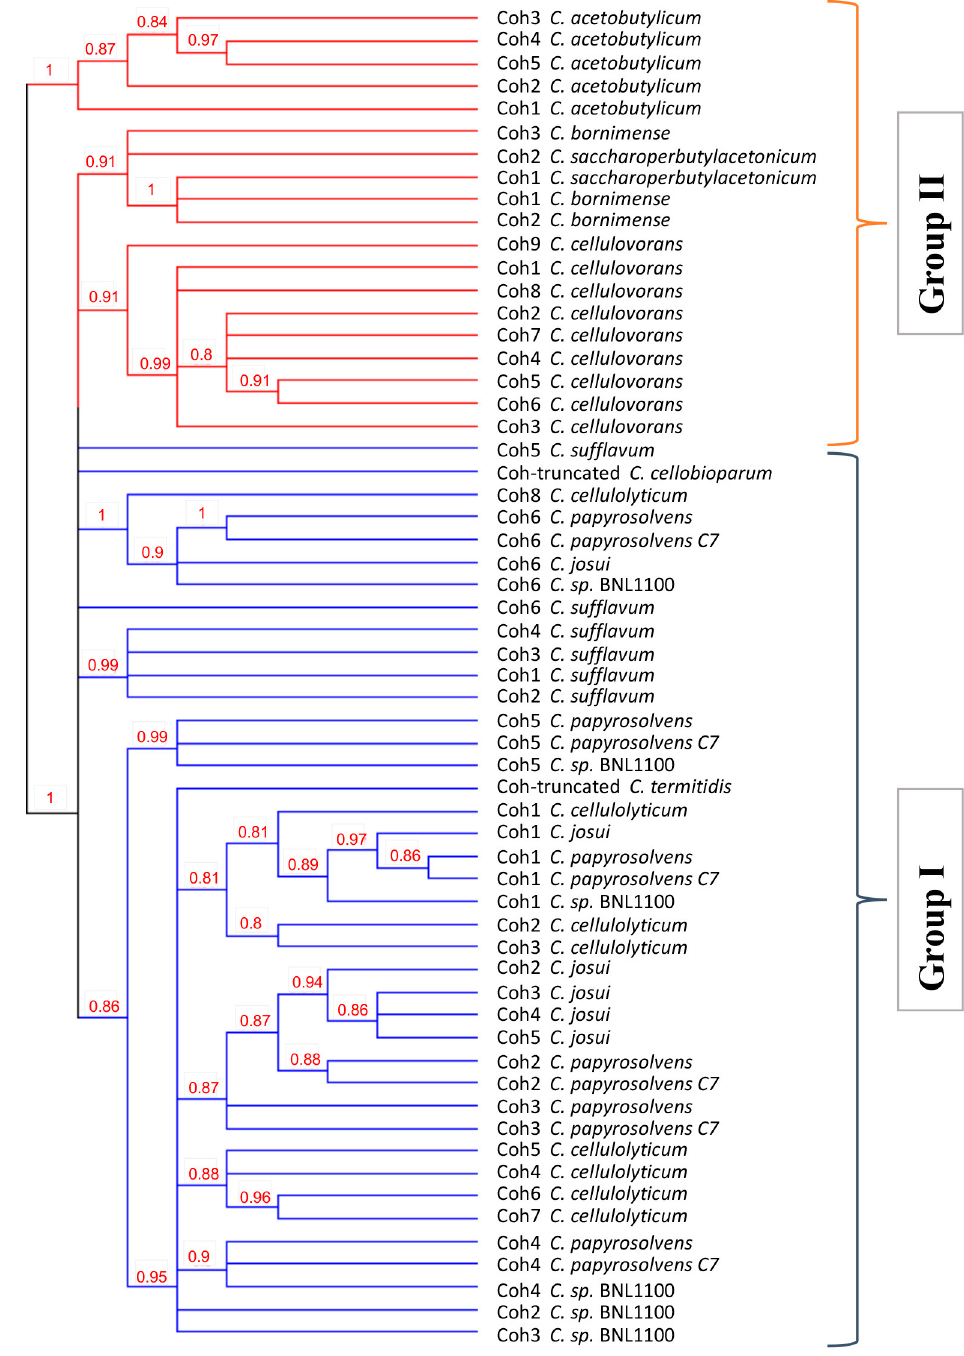
Figure 4. Phylogenetic relation of cohesin modules from the major scaffoldins of mesophilic cellulolytic clostridia. Protein sequences of major scaffoldin cohesins were aligned and analyzed by PhyML. Bootstrap values are denoted, and branches below 80% bootstrapping were collapsed. Two major branches of the dendogram (red and blue) separate between C. acetobutylicum , C. cellulovorans , C. bornimense , and C. saccharoperbutylacetonicum from the other mesophiles.